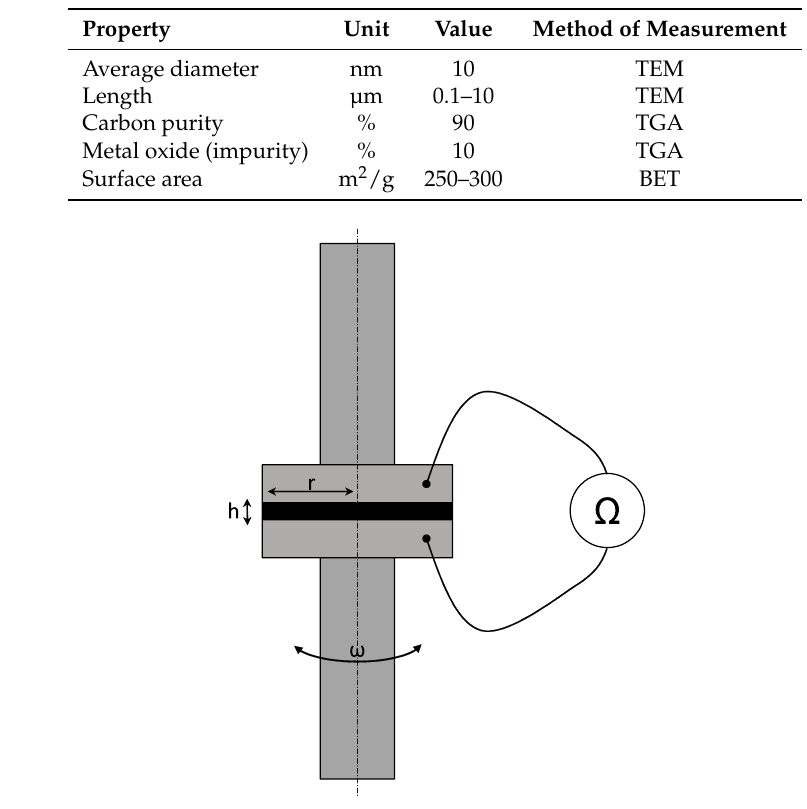
Figure 2. Rheo-electrical test